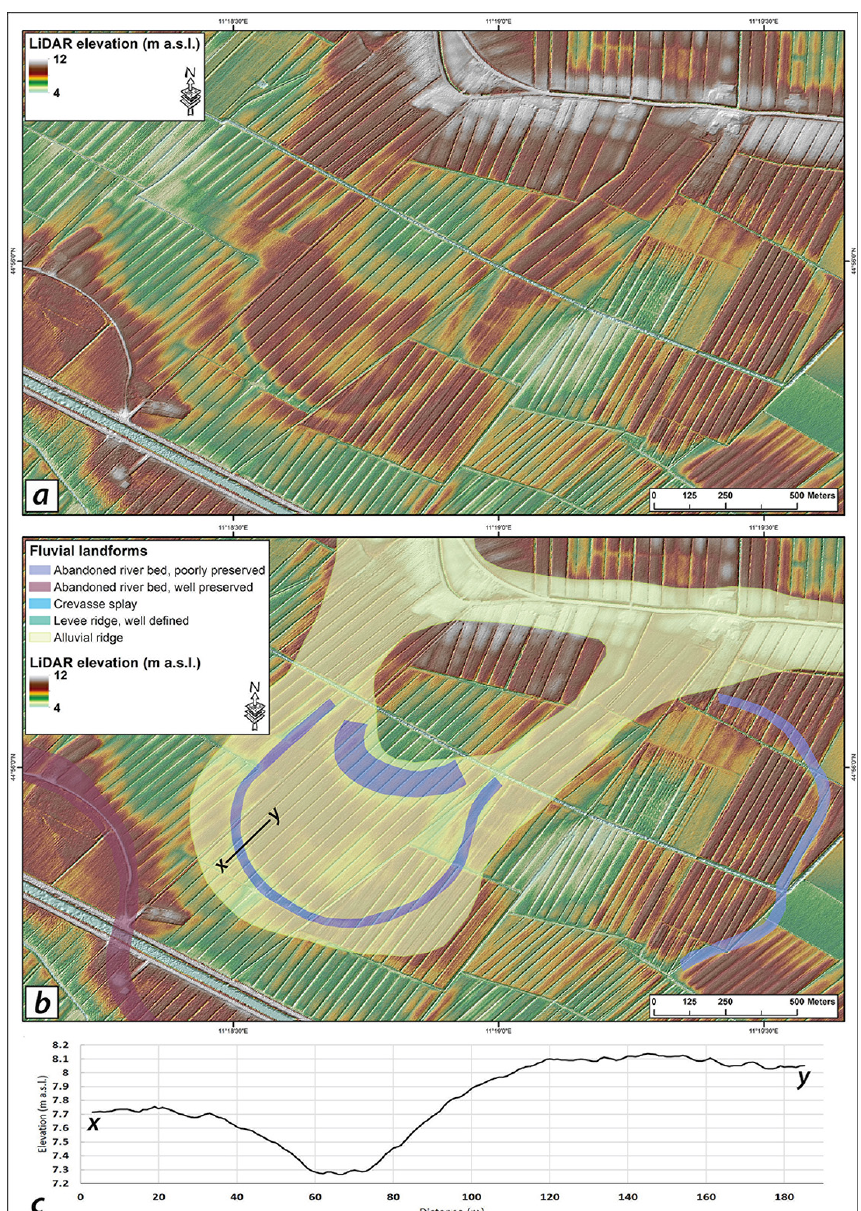
Figure 5. Example of improved high-resolution lidar-derived digital elevation model and application in geomorphological mapping from an area north of Gavello (FE), northern portion of the study area (see Fig. 1 for location): (a) 1m lidar DTM with no interpretation; (b) same area showing subtle fluvial landforms like alluvial ridges and abandoned riverbeds; (c) topographic profile (black line in Fig. 5b) showing the subtle morphologic expression (total relief less than 1m) of the abandoned